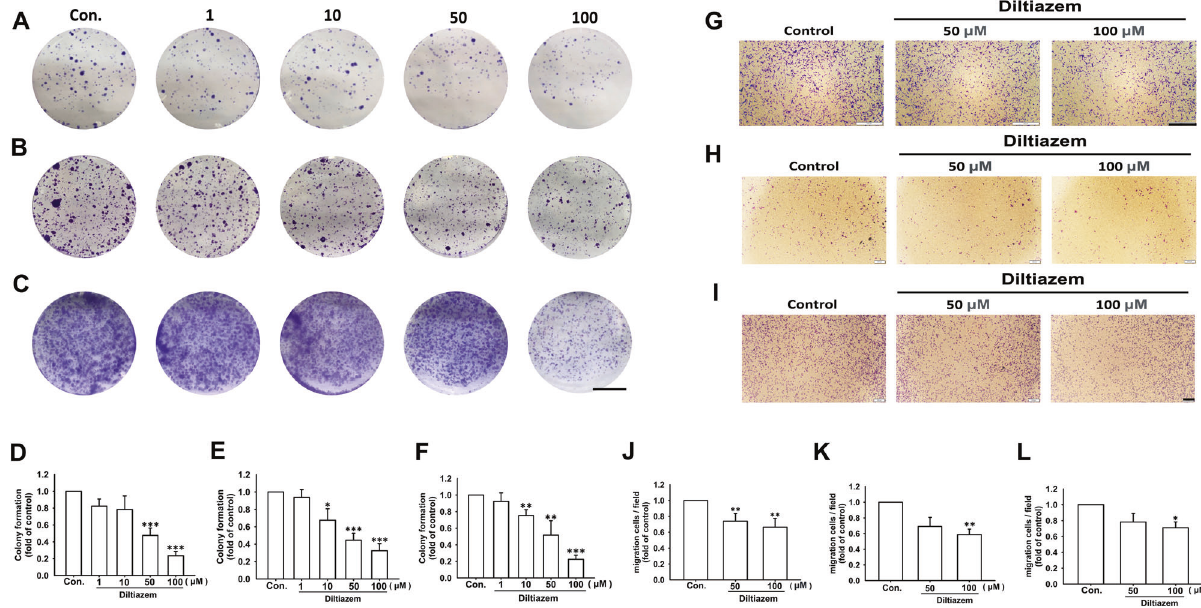
Fig. 1 Colony formation and cell migration are inhibited by diltiazem in breast cancer cell lines. After diltiazem treatment (1 – 100 μ M) for 10 days, the number of colonies formed (bigger than 1 mm in diameter) were counted. Note that colony formation of JC ( A , D ), 4T1 ( B , E ), and MDA-MB-231 cells ( C , F ) were all inhibited by diltiazem. Scale bar, 1 cm. In cell culture insert system, diltiazem (50 or 100 μ M) treatment for 24 h also reduced cell migration in JC ( G , J ), 4T1 ( H , K ), and MDA-MB-231 cells ( I , L ). Scale bar, 400 μ m. Graphs showed mean ± S.D. of